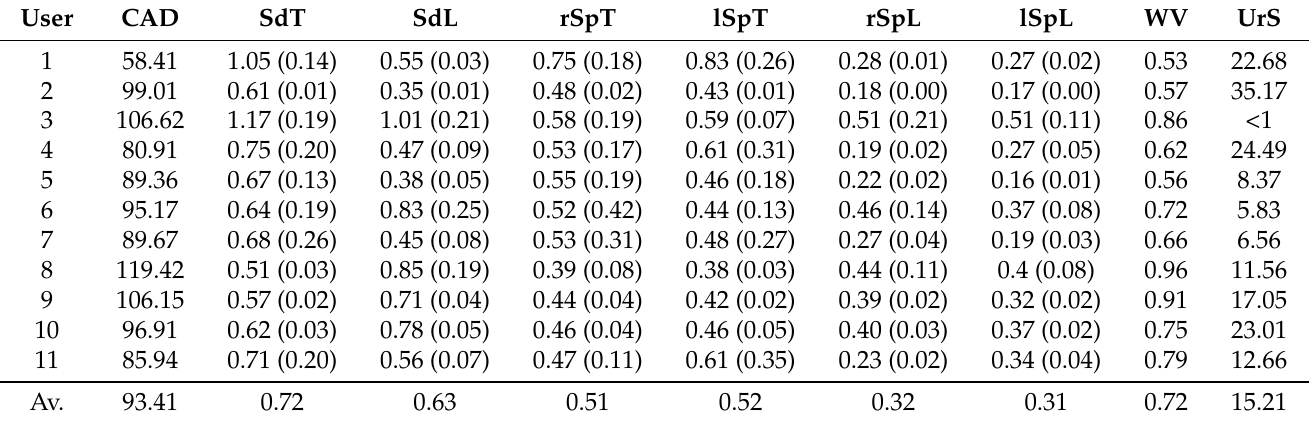
Table 2. User gait